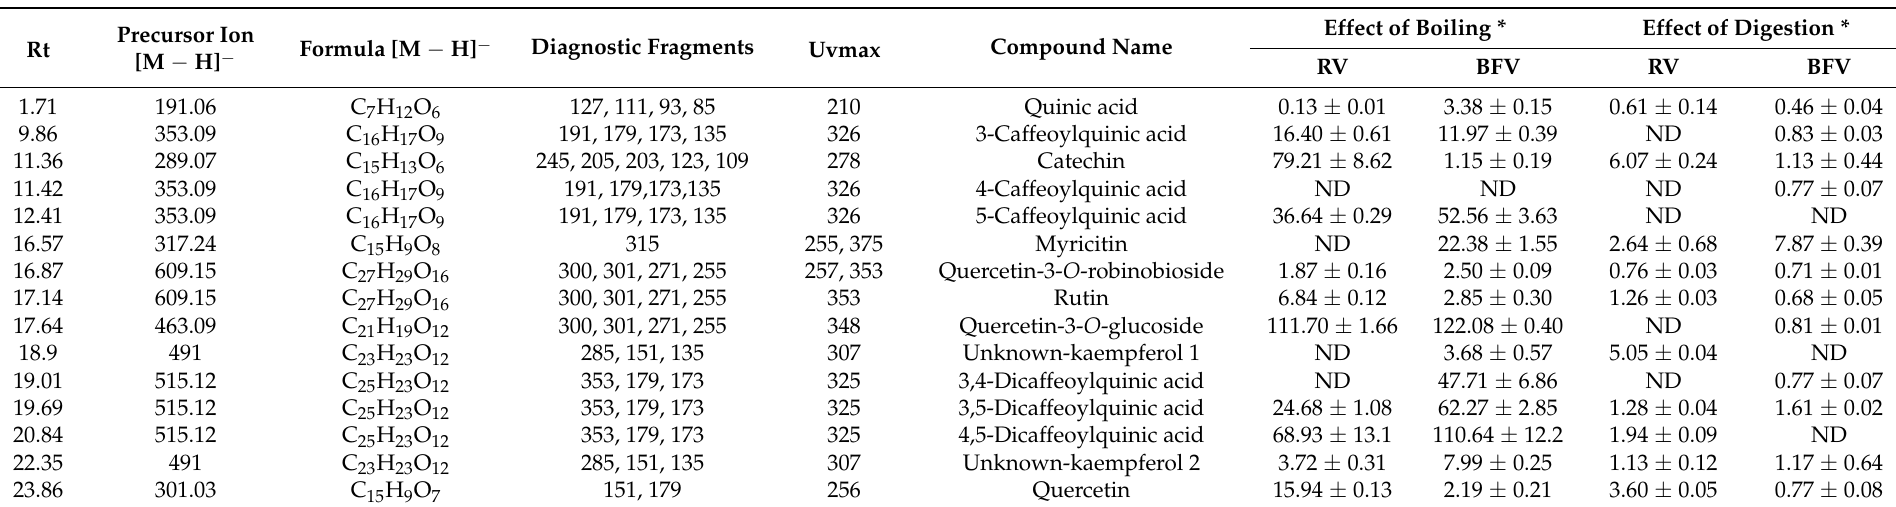
Table 1. Compounds identified in African pumpkin undigested (raw and boiled) extracts and digested (raw and boiled)